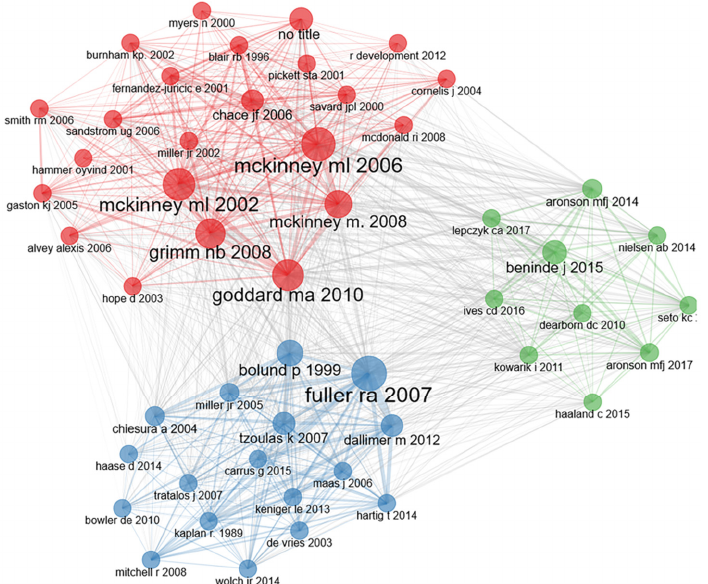
Figure 4. Co-citation network. Green, red, and blue represent the first, second, and third article clusters, respectively. clusters,